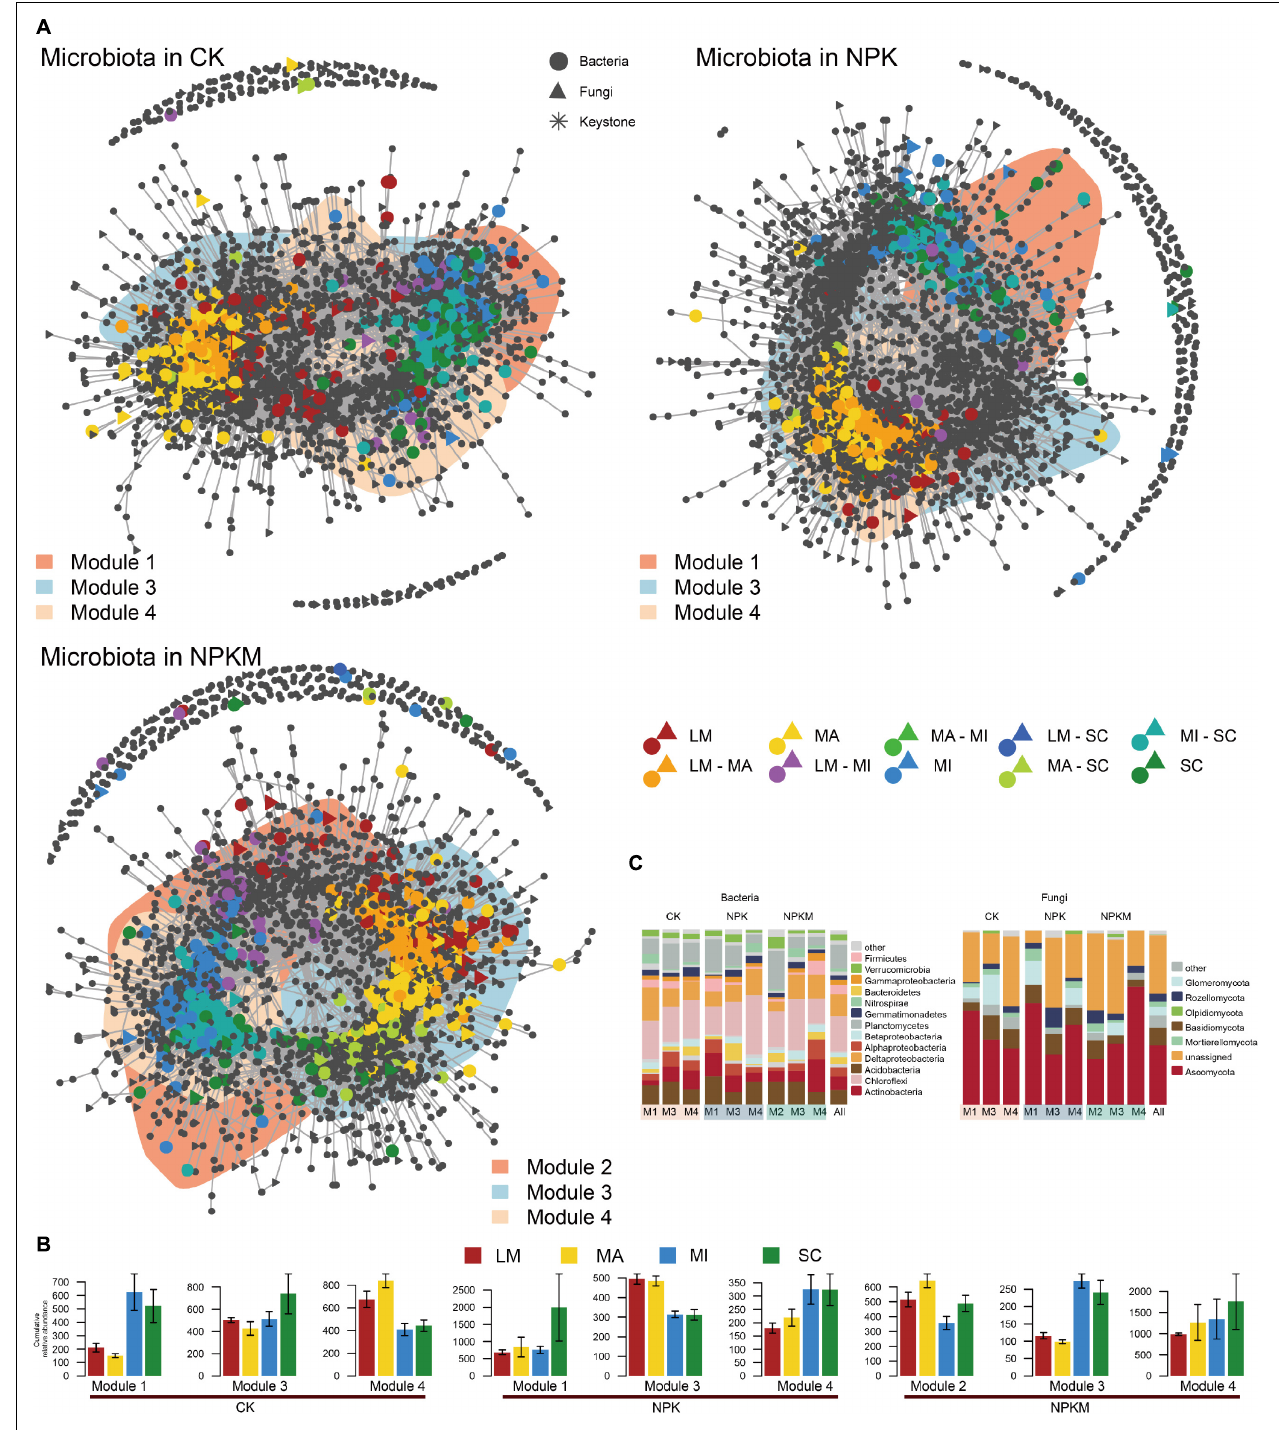
FIGURE 4 | Co-occurrence patterns of soil aggregation sensitive OTUs under different fertilization regimes. (A) Co-occurrence networks visualizing significant correlations ( p < 0.001; indicated with gray lines) between soil bacterial and fungal OTUs under different fertilization regimes. Circles indicate bacteria, triangles fungi and asterisks indicate keystone OTUs. Soil aggregation sensitive OTUs are colored and shade area are represented the network modules (the OTUs in each module are defined in Supplementary Figure 4 ). (B) Cumulative relative abundance (as counts per million, CPM; y -axis in × 1000) of all soil aggregation sensitive bacteria and fungi in each module under different fertilization regimes. (C) Qualitative taxonomic composition of soil aggregation sensitive modules is reported as proportional OTUs numbers per phylum and compared to the overall taxonomic distribution in the entire dataset (column ‘all’). See Figure 1 .